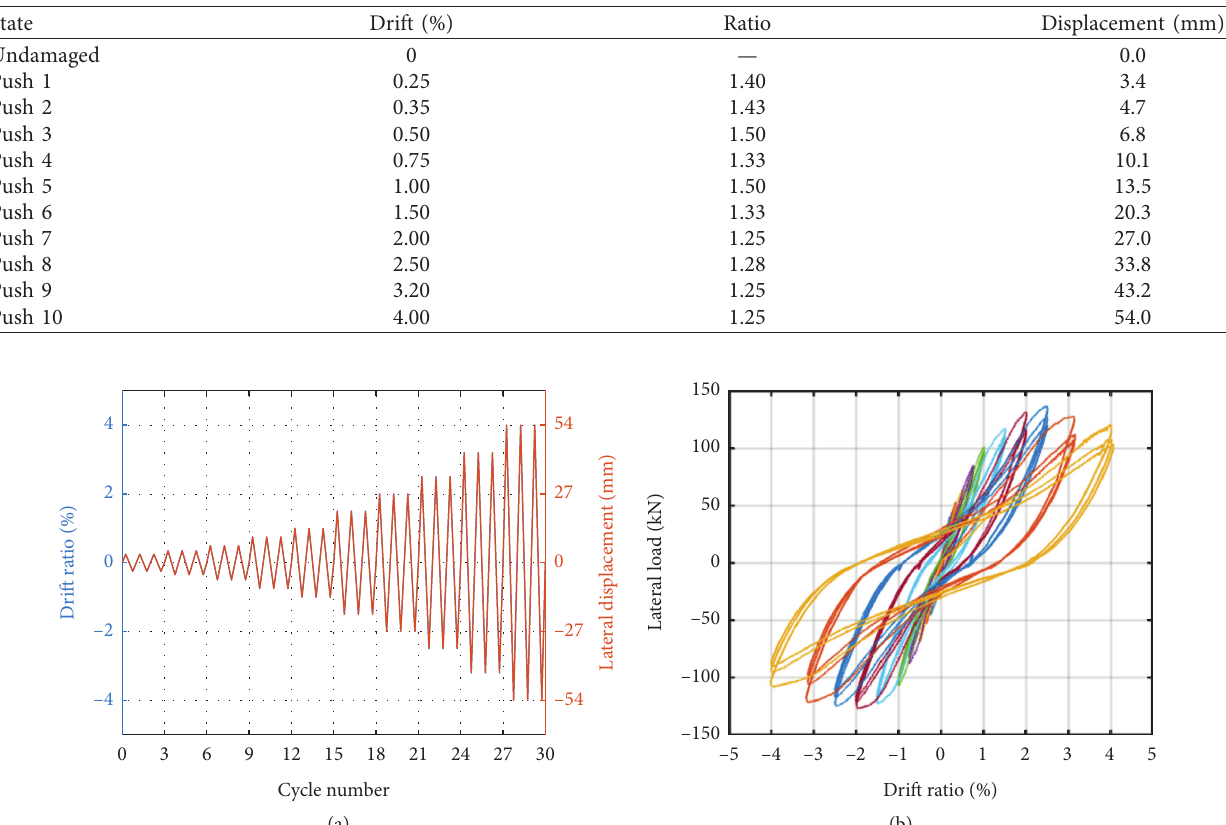
Table 1: Summary of pushover tests and the damage states.